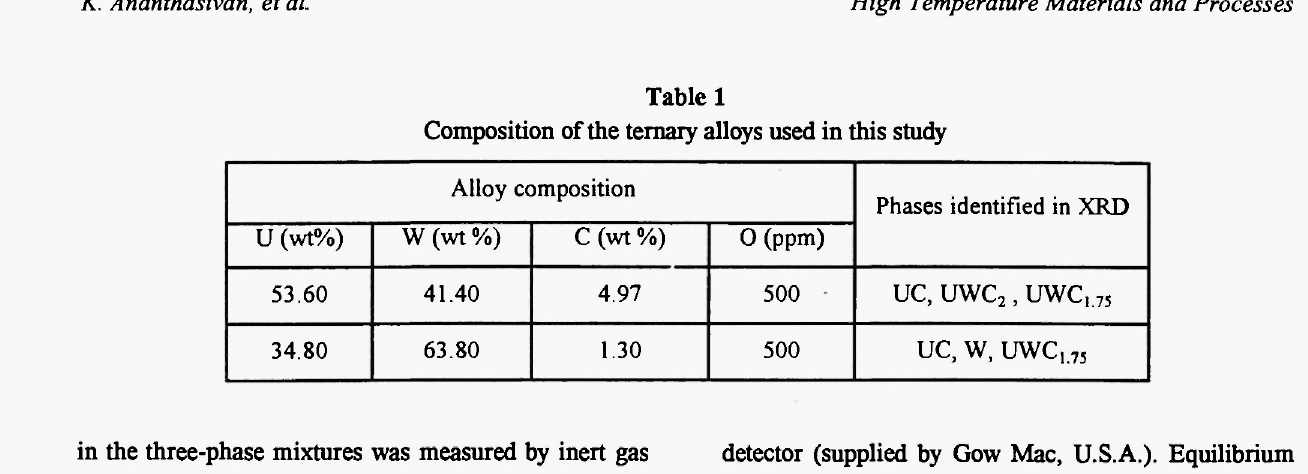
Composition of the ternary alloys used in this study Alloy composition